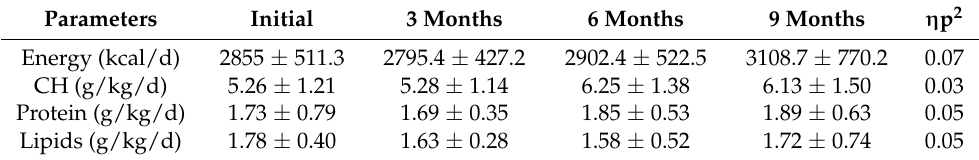
Table 2. Energy and macronutrient intake in the runners during the season.